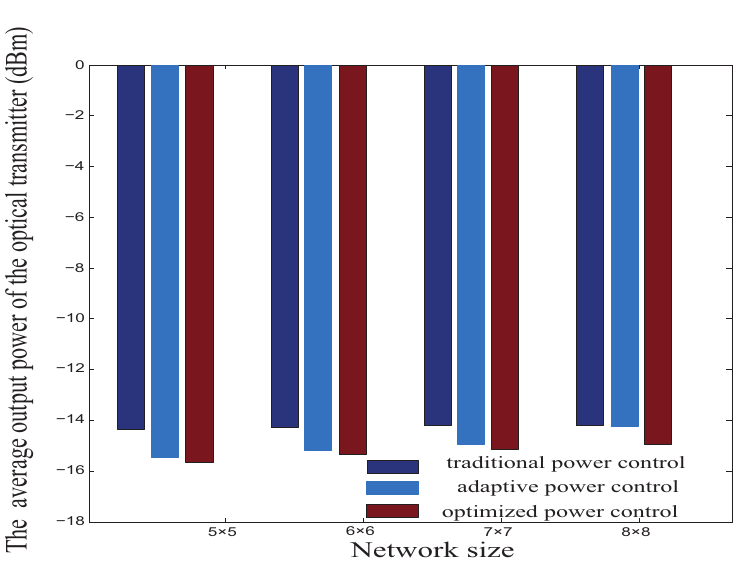
Figure 8. The average output power of the optical transmitter in M × N mesh-based ONoCs.